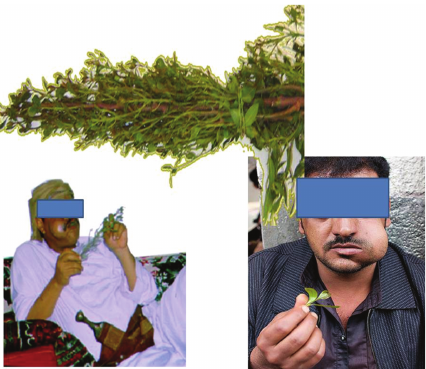
Figure 1: Khat tree and how khat users chew and keep it for few hours in their mouth